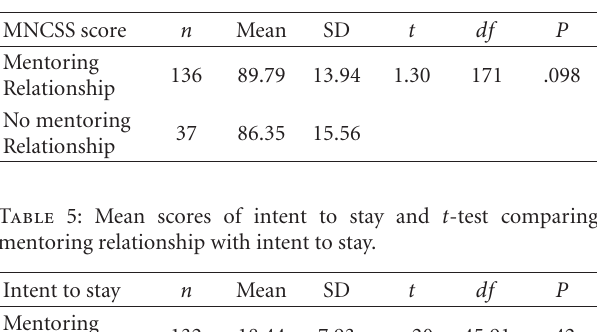
Table 4: Mean scores of career satisfaction and t -test comparing mentoring relationship and career satisfaction.